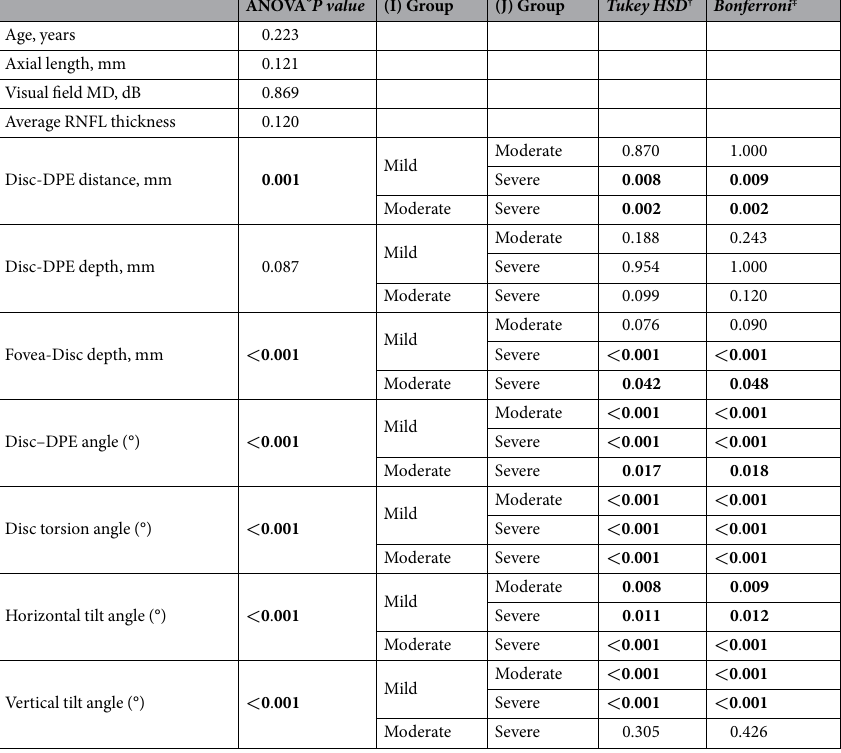
Table 2. Multiple comparisons of the 3 groups using the ANOVA and the post-hoc analysis. * Analysis of variance for the difference analysis among groups. † Tukey’s honest significance test for post-hoc anaylsis. ‡ Bonferroni method for post-hoc